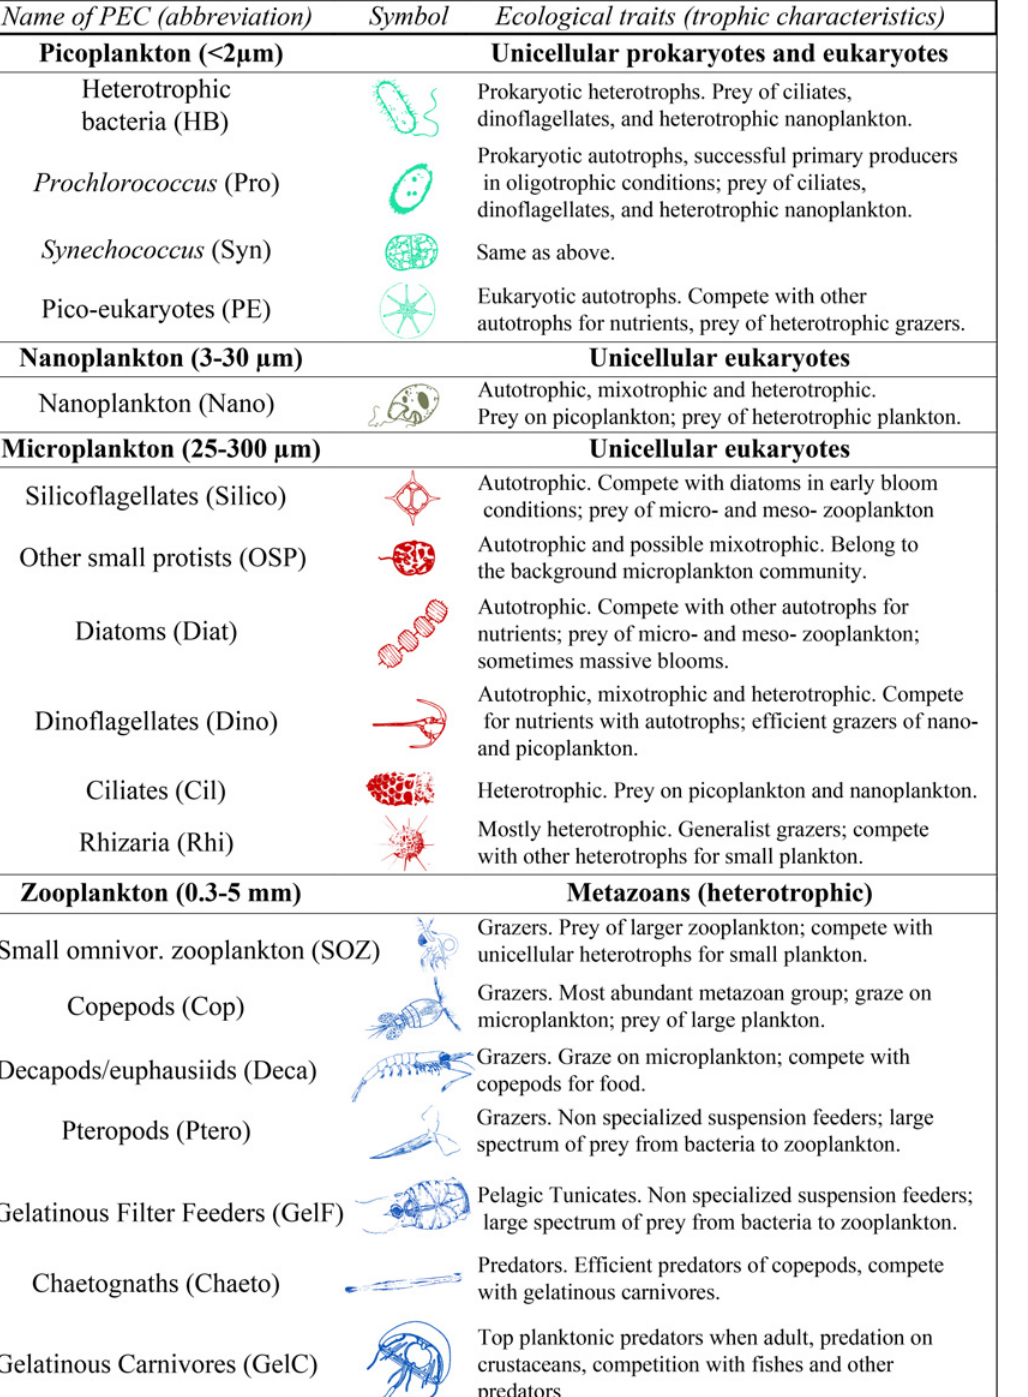
PLOS ONE | DOI:10.1371/journal.pone.0119219 March 17,